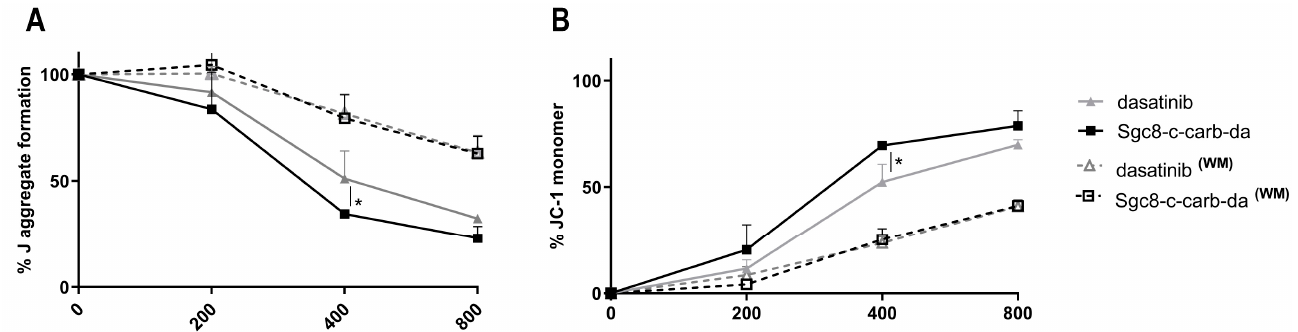
Figure 5. Changes in mitochondrial membrane potential induced by Sgc8-c-carb-da . Quantification of the JC-1 assay obtained from incubation of the A20 cell line with 200, 400, and 800 nM of dasatinib or Sgc8-c-carb-da for 24 h, with (WM) or with the washing method (60 min of drug exposure followed by a wash and further incubation). ( A ) Percentages of J-aggregate formation and ( B ) percentages of JC-1 monomer retention are shown. Graph shows mean ± SD, n = 3 per condition. * p < 0.05 (Student’s t -test).